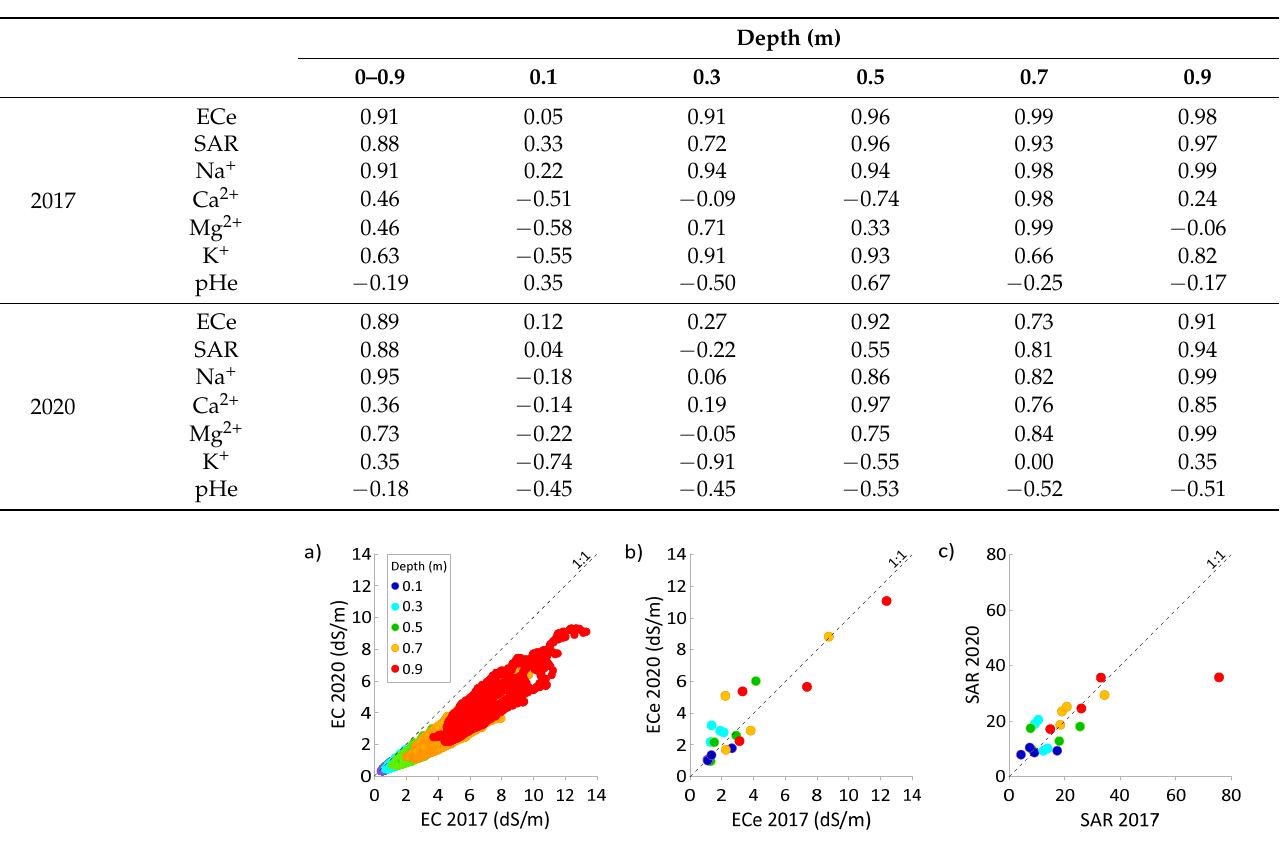
Figure 7. Relationships between ( a ) EC; ( b ) ECe; and ( c ) SAR for 2017 and 2020.